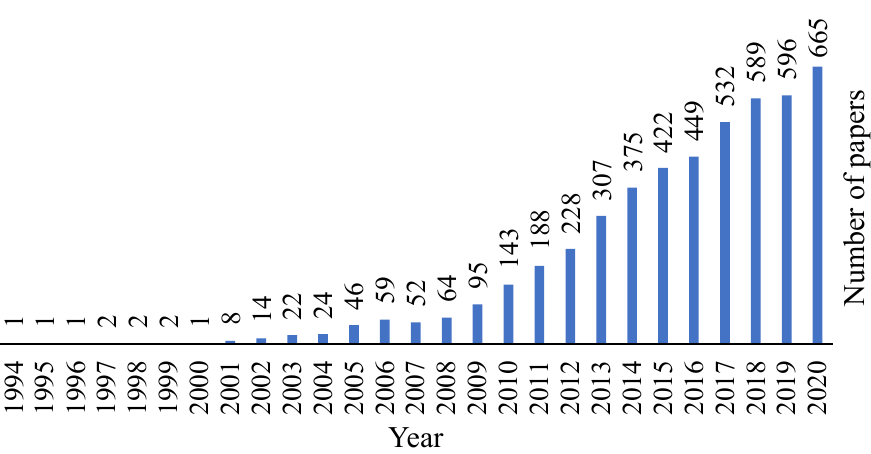
Figure 3. Evolution of the decellularization area over the years. Retrieved from PubMed.org with the research designation “decellularization”, where 4140 results were found.